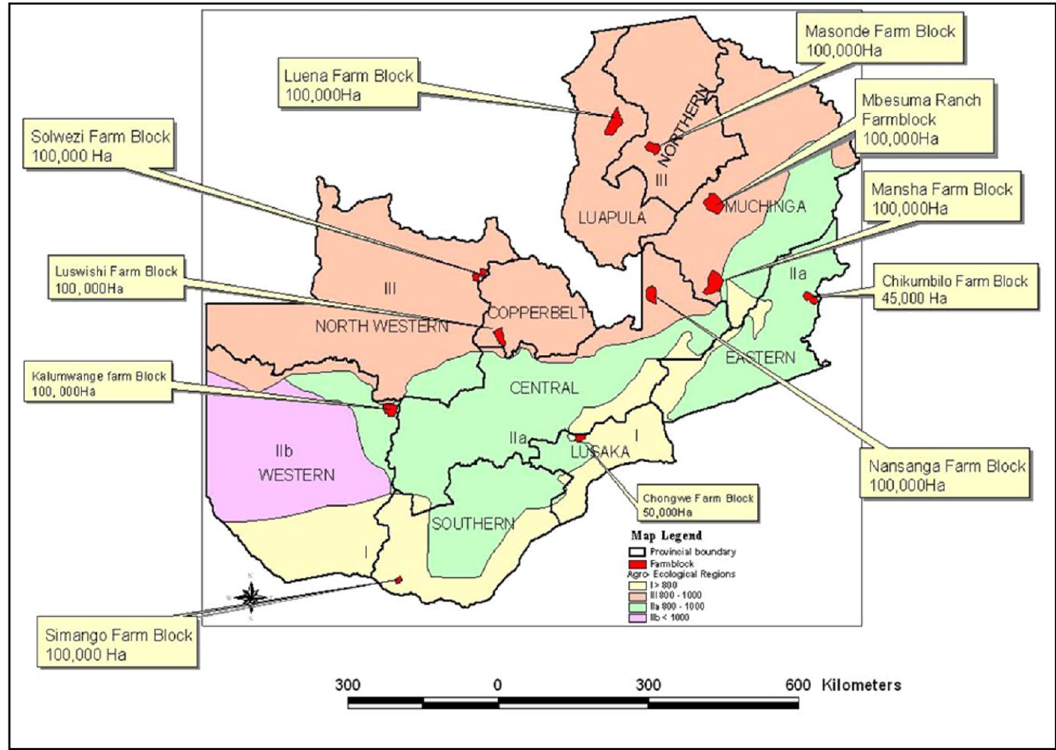
Figure 1: Location of farm blocks ( both established and proposed ) in relation to the nine provinces of Zambia. Source: Zambian Department of Agriculture on 24 May